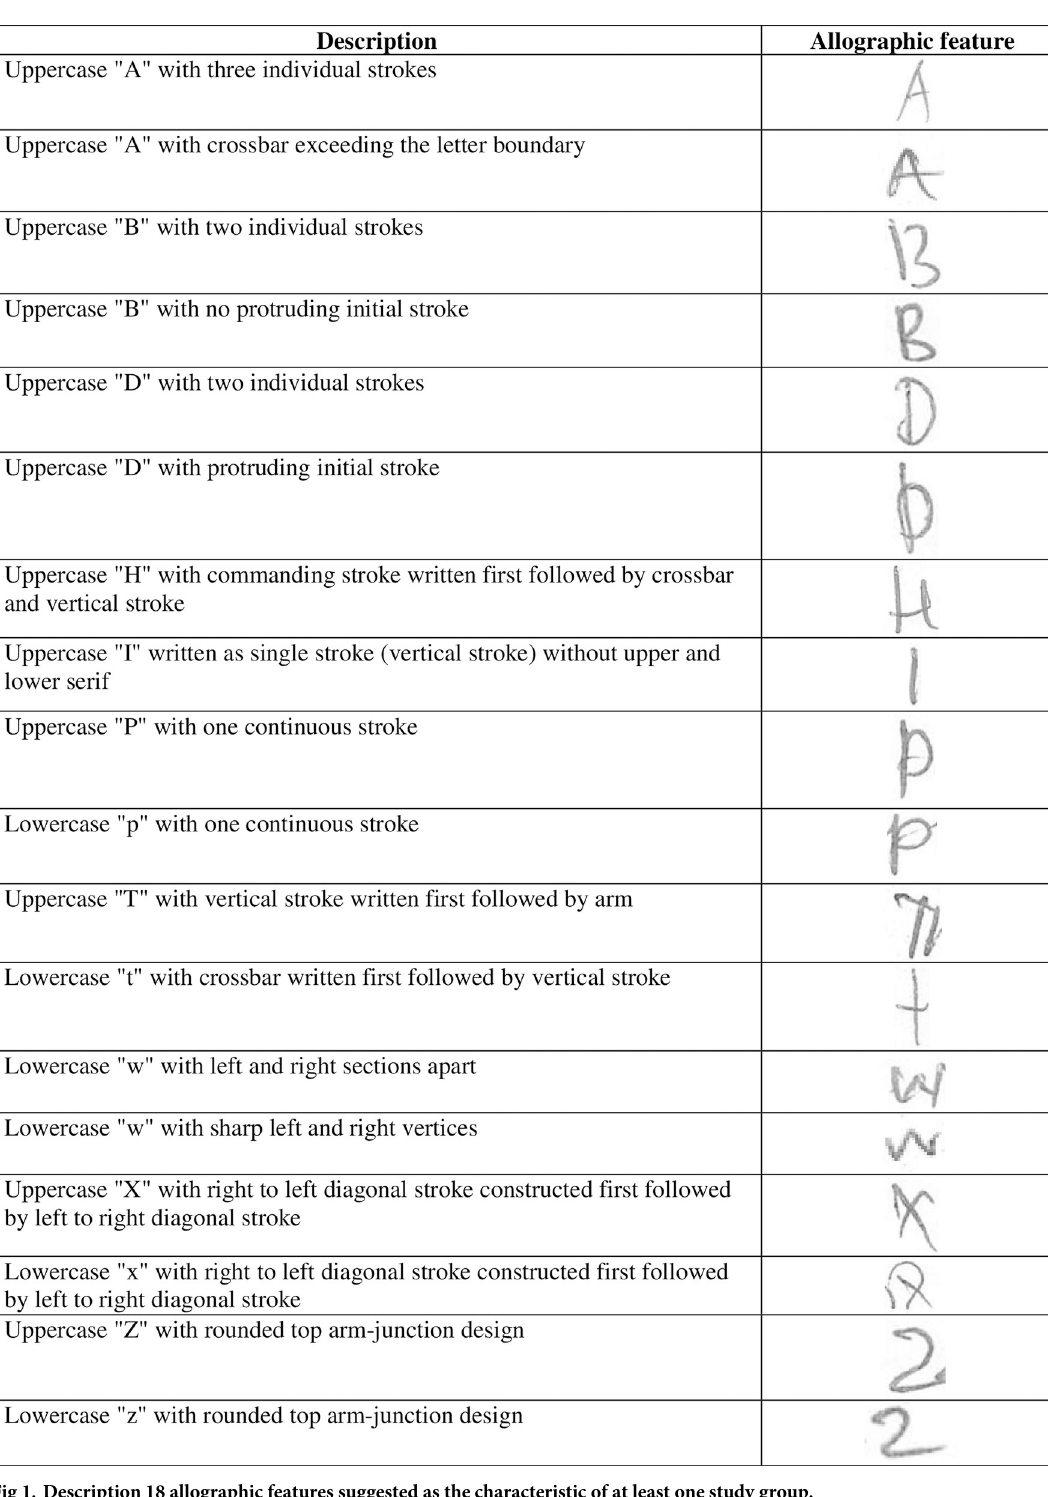
Fig 1. Description 18 allographic features suggested as the characteristic of at least one study group.